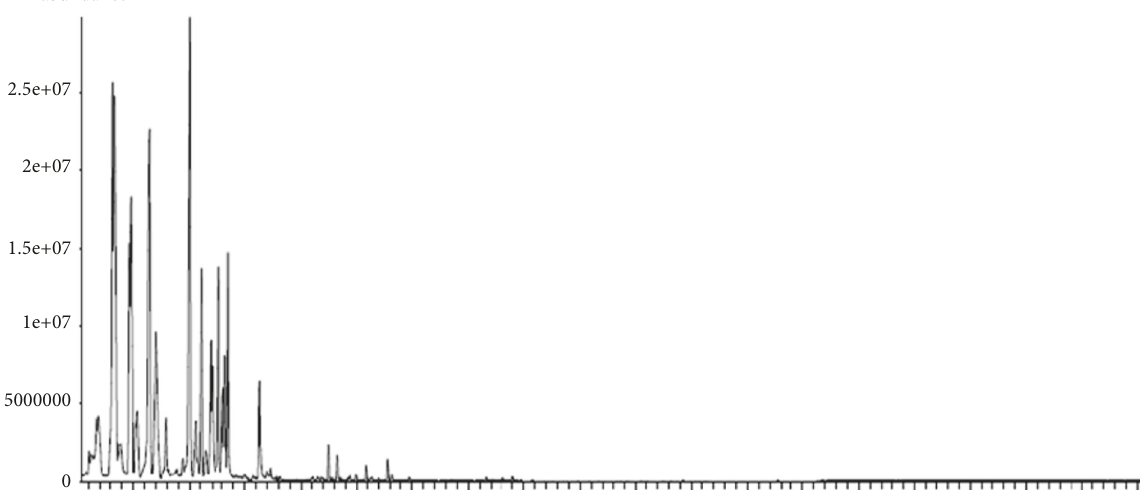
Figure 4: Chromatogram of essential oils of rosemary extracted by MAH.